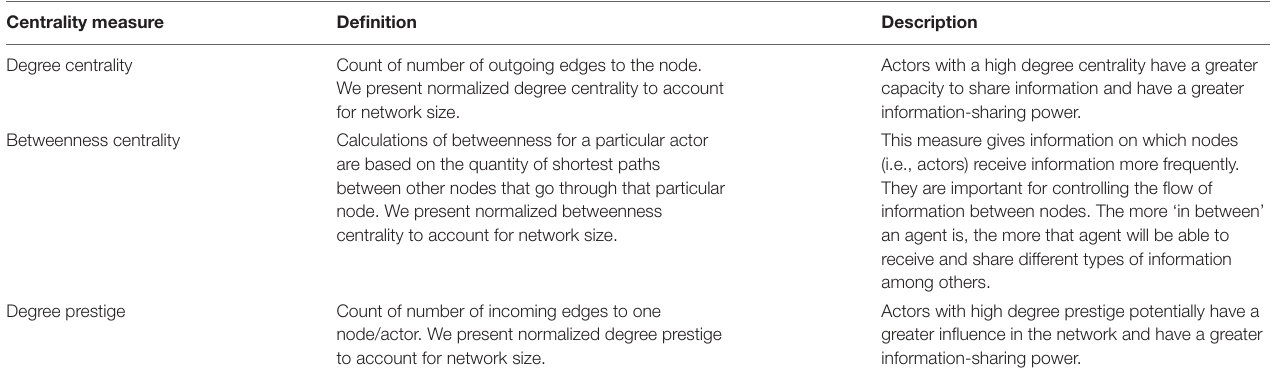
TABLE 2 | Individual and organisational level network metrics of centrality, definitions, and